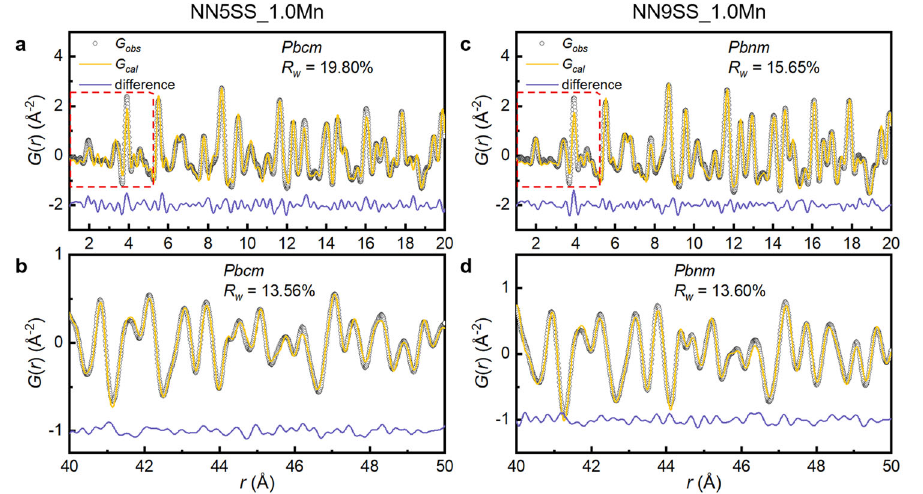
Fig.4|PDFanalysisofantiferroelectricandrelaxorstates. X-raypairdistributionfunction G ( r )analysisof( a , b )NN5SS_1.0Mnand( c , d )NN9SS_1.0Mnsamplesinthe r range of 1 − 20Å and 40 − 50Å with the Pbcm and Pbnm space groups, respectively. The poor fi t to the PDF below 5Å is highlighted by dashed red squares.